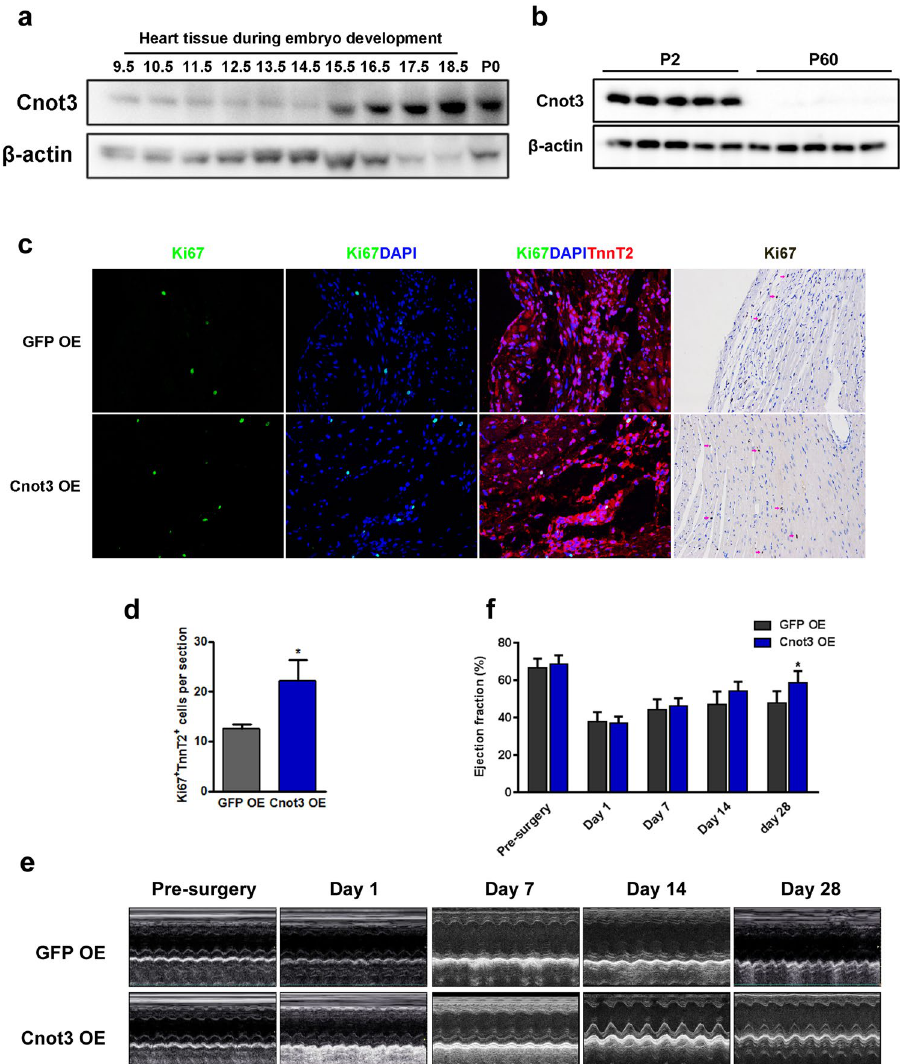
Figure 6. Cnot3 plays a critical role in cardiomyocyte proliferation in vivo . ( a ) Western blots to show Cnot3 protein level in developing hearts from mouse embryos at indicated time points. β -actin was used as loading control. The blots were cropped since different antibodies were incubated at the same time. ( b ) Western blot to show Cnot3 protein level in mouse neonatal hearts versus adult hearts. β -actin was used as loading control. The blots were cropped since different antibodies were incubated at the same time. ( c ) Representative images of immunofluorescence or immunochemical staining against Ki67 to show the impact of Cnot3 overexpression on cardiomyocyte proliferation in a mouse myocardial infarction model (See experimental procedures for details). DAPI (blue) was used to stain the cell nuclei. Magnification: 100x. ( d ) Statistical analysis of (C). Ki67 + TnnT2 + cells were counted from 10 sections per mouse, 6 mice per group, values were plotted as mean ± SEM from three independent experiments, * p < 0.05. ( e ) Representative images of echo to show heart functions in GFP overexpression or Cnot3 overexpression hearts at indicated time points, respectively. ( f ) Statistical analysis of ( e ). Values were calculated as fractional shortening, and plotted as mean ± SEM. n = 6 per group, * p <